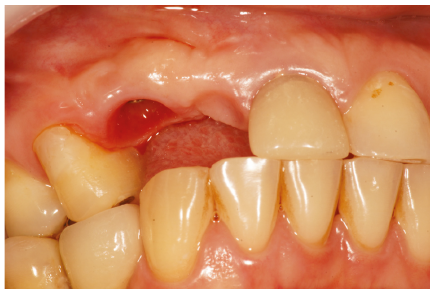
Figure 7: Buccal view of the gingival conditioning.